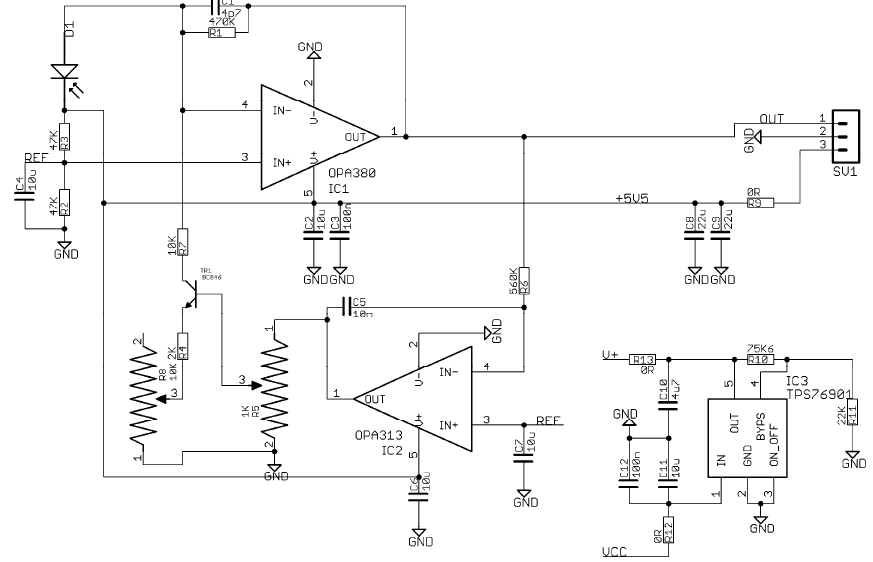
Figure A4. Photodiode receiver. It is based on the OPA380 transimpedance amplifier. The IC9 with the TR1 transistor functions as a feedback amplifier. Only the DC component of the IC8 output passes through IC9. The output of IC9 controls the conductivity of TR1, which in turn, subtracts the photodiode’s DC current. Therefore, the input of IC8 is contains only the AC component of the current. This way, the sensor can function in the presence of sunlight. Without the feedback loop, it would not be possible to function properly due to the high amplification of the OPA380 (470K feedback resistor).